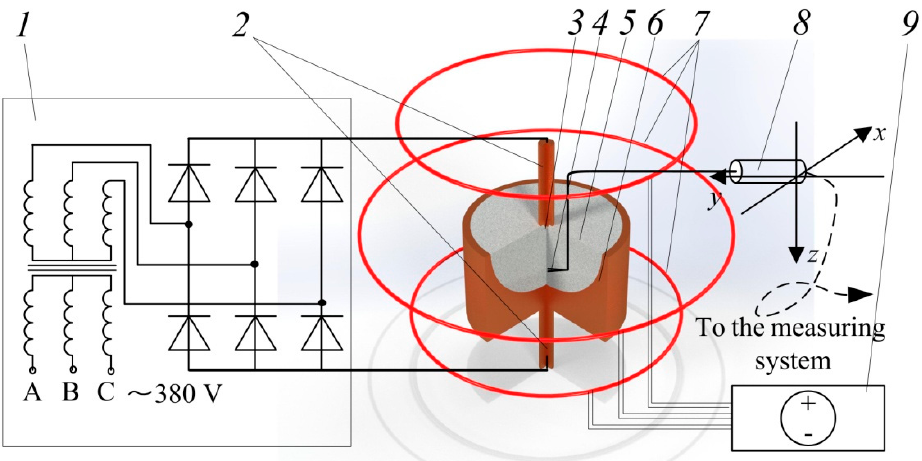
Figure 2. Experimental setup. 1 —power supply (thre-pase rectifier); 2 —current leads; 3 —small elec- trode; 4 —thermocouple probe; 5 —eutectic alloy In-Ga-Sn; 6 —big electrode-container; 7 —Maxwell coil; 8 —3D coordinate system for probe; and 9 —power supplu for Maxwell coil.